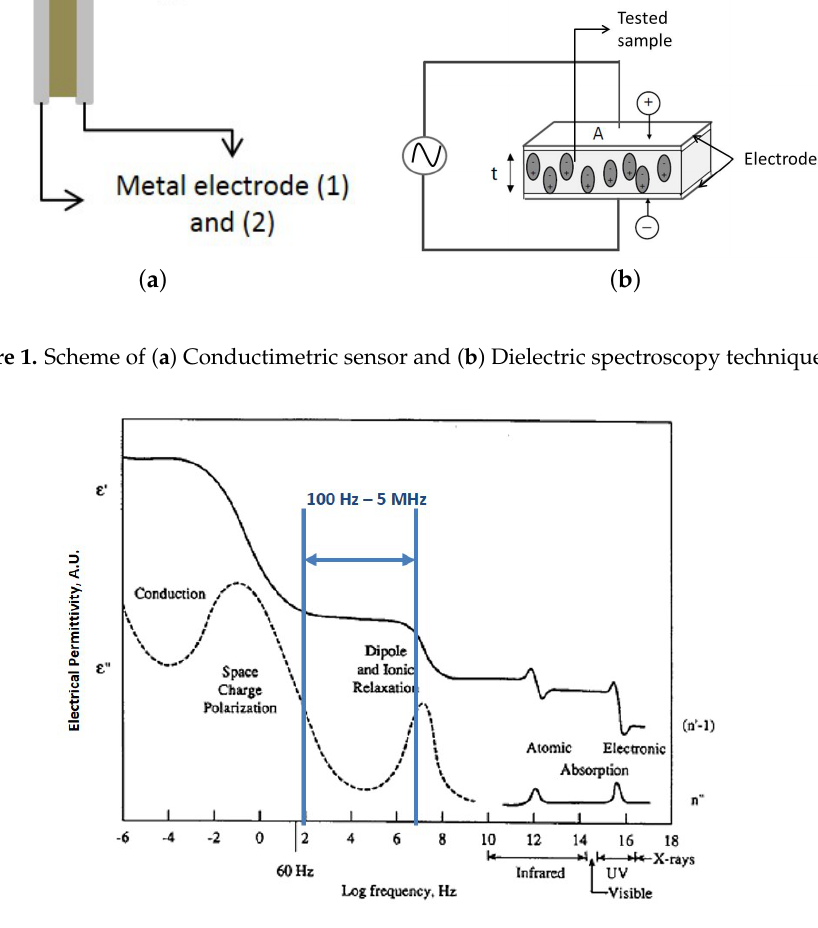
Figure 2. Dielectric response according to frequency. Adapted from